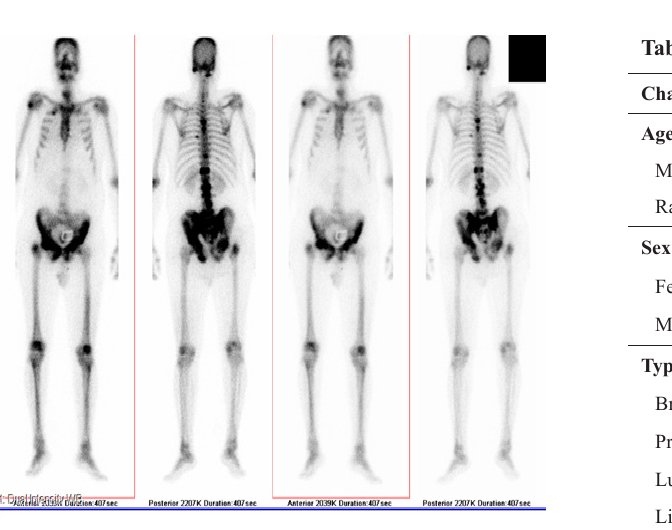
Figure 3: Prostate cancer with extensive bone metastases involving both femora, all pelvic bones, lumber and dorsal vertebrae and